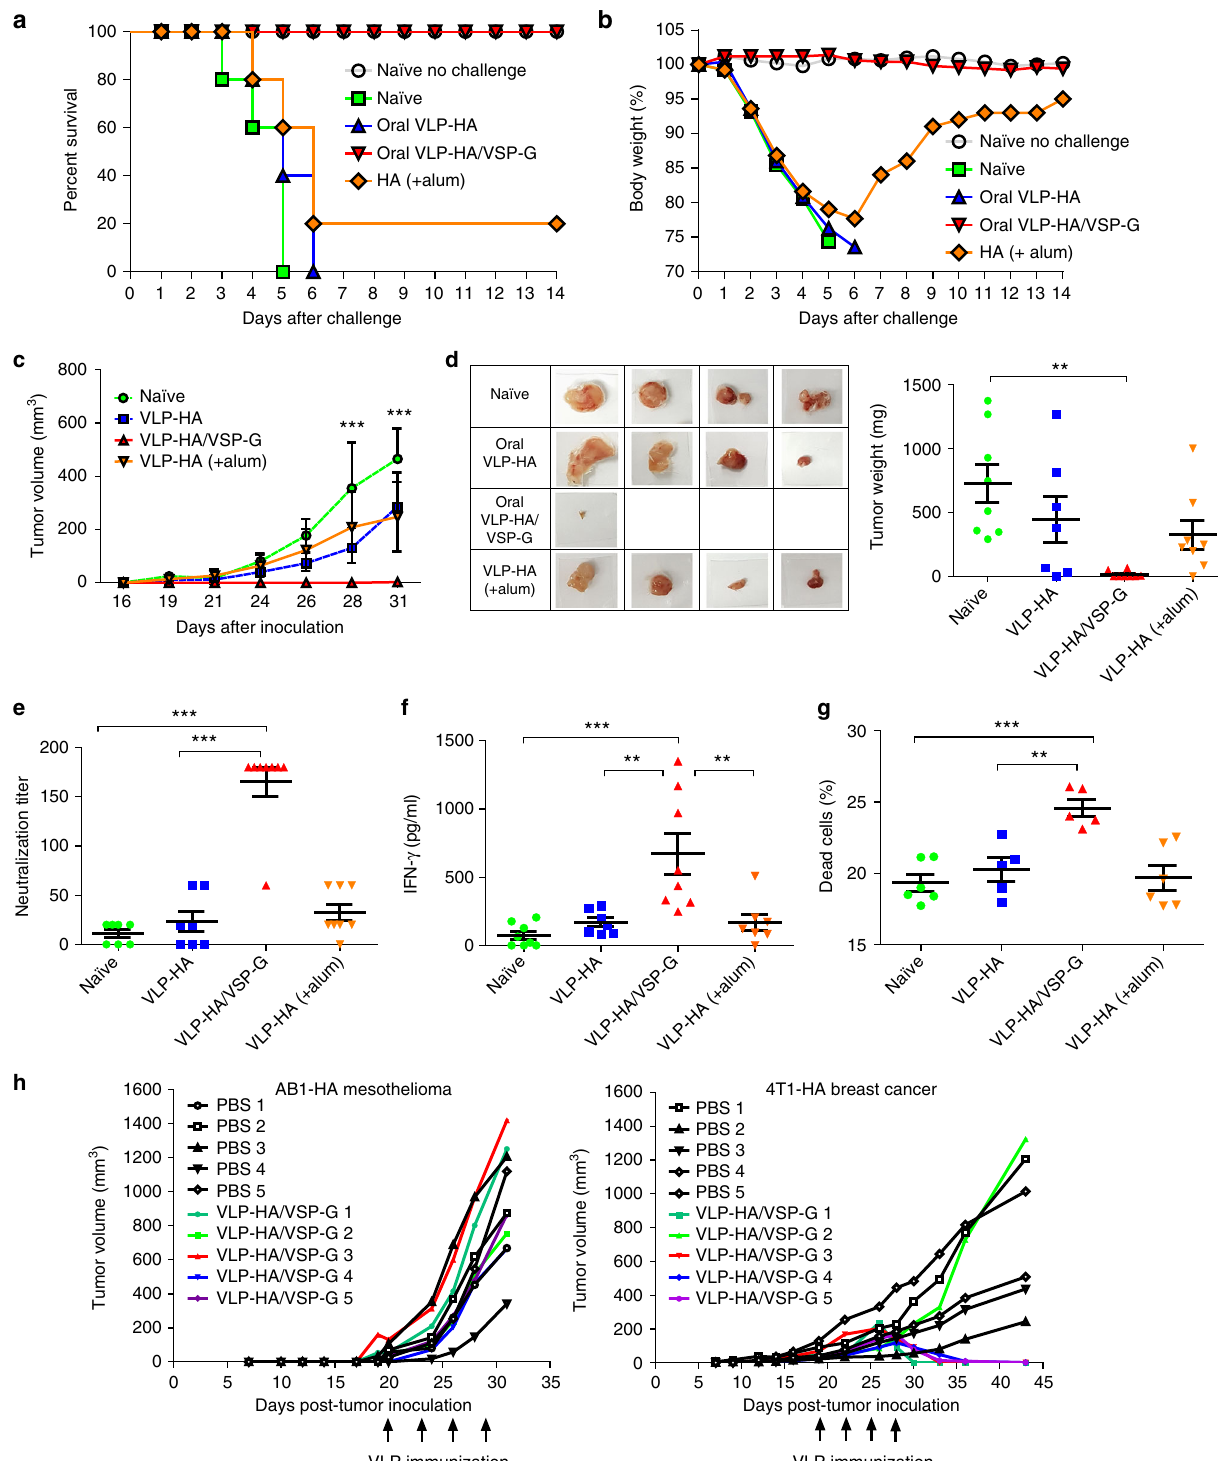
the completion of the high-resolution structures of Δ VSP and Δ VSP-antigen complexes, which has been elusive until now, will allow a better understanding of the mechanism by which VSPs interact and protect heterologous antigens from the action of proteolytic enzymes. VSPs not only protected HA from degradation but also enhanced the in vitro immunogenic properties of VLP-HA. Particle binding and uptake, up-regulation of co-stimulatory